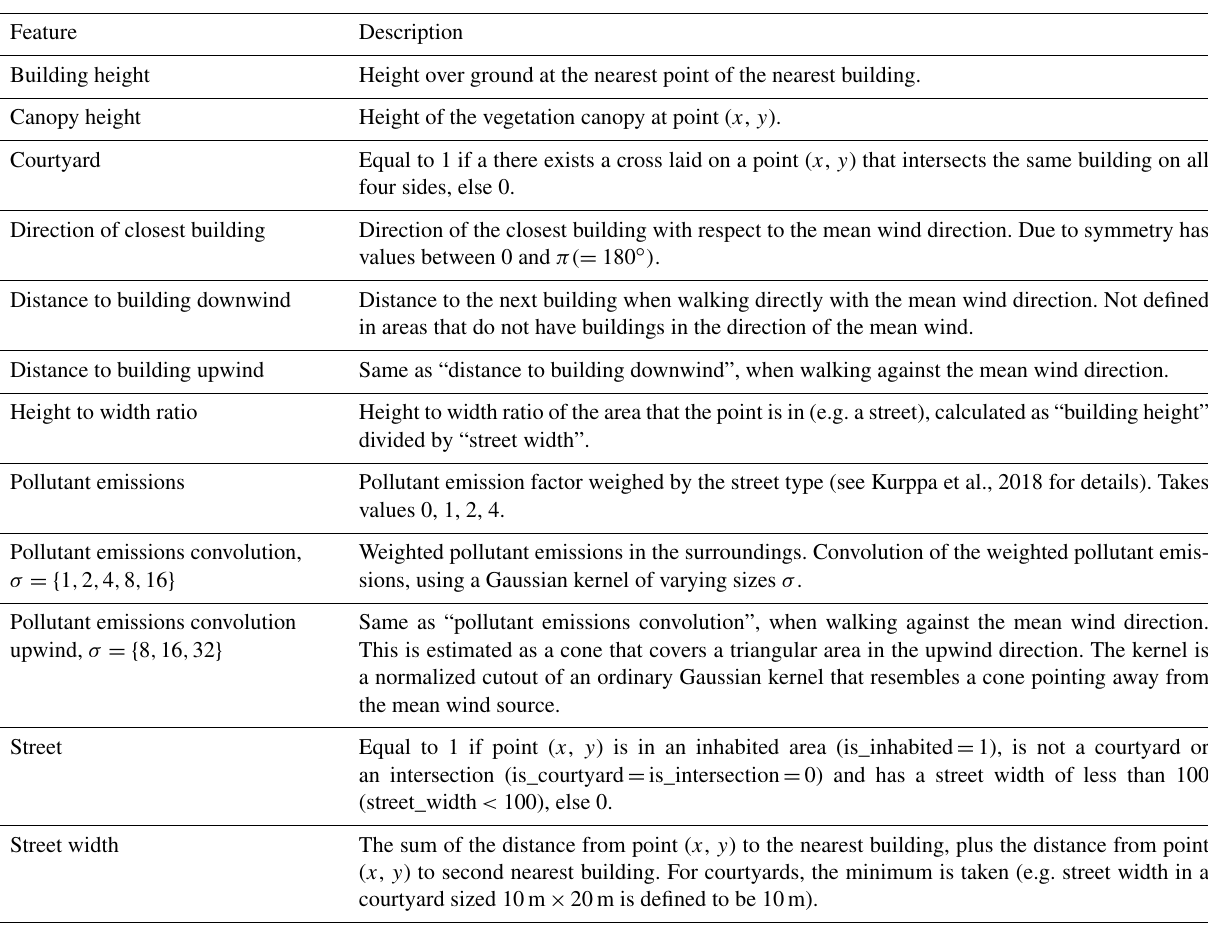
Table A1. Detailed descriptions of features in Table 1. The Supplement contains visualizations of these features. Note that these features were computed with the help of auxiliary features that are not listed here, such as is_building, is_inhabited and is_intersection. For more details, see the supplied software